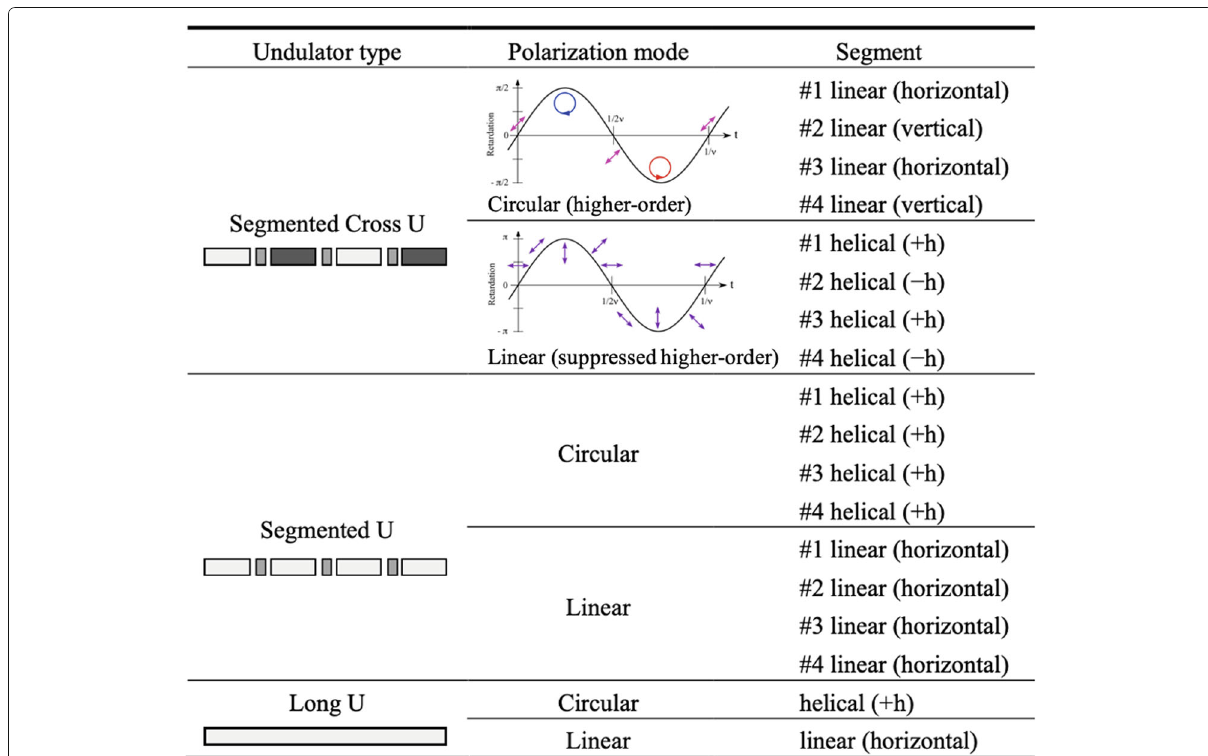
Fig. 32 A list of polarization examples that are prepared by combinations of polarization modes in the units of a segmented undulator (U) [34]. A single undulator (Long U) is shown for a